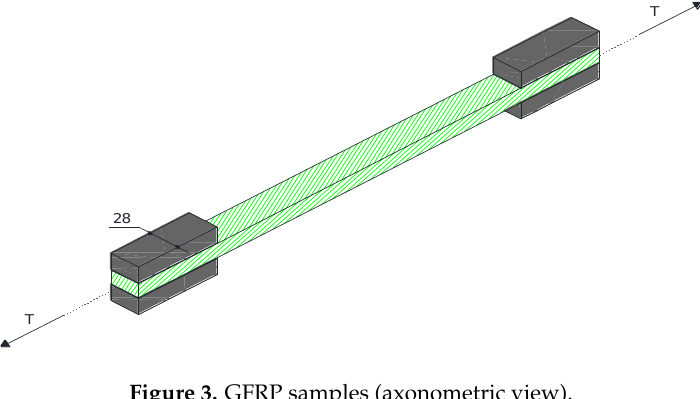
Figure 3. GFRP samples (axonometric view).